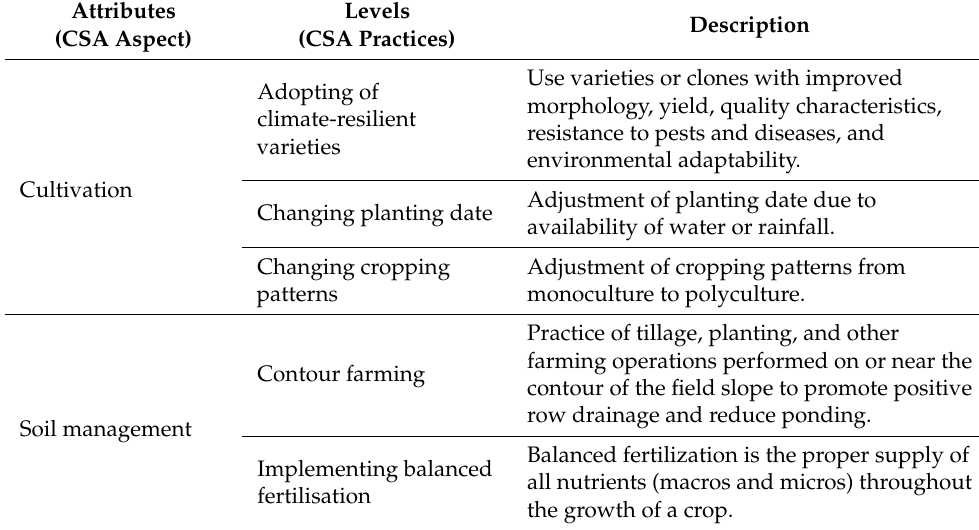
Table 3. CSA practices in smallholder coffee